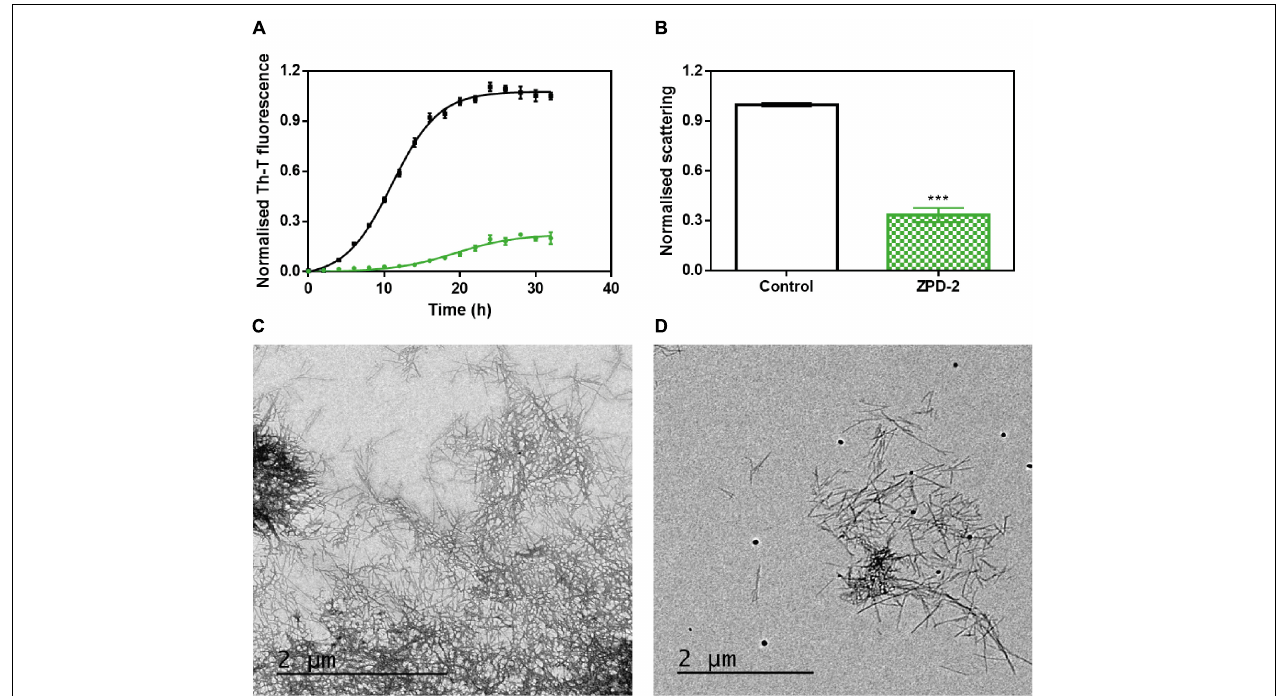
FIGURE 2 | ZPD-2 inhibits the aggregation of wild-type α -synuclein in vitro . (A) Aggregation kinetics of α -Syn in absence (black) and presence (green) of ZPD-2. Intensity of Th-T fluorescence is plotted as a function of time. (B) Light scattering of end-point aggregates is measured at 300 nm for untreated (white) and ZPD-2-treated samples (green). (C,D) Representative TEM images of untreated (C) and ZPD-2-treated (D) samples. Th-T fluorescence is expressed as normalized means. Final points were obtained at 48 h after the aggregation reaction begin. Error bars are shown as standard errors of mean values, ∗∗∗ p < 0.001.